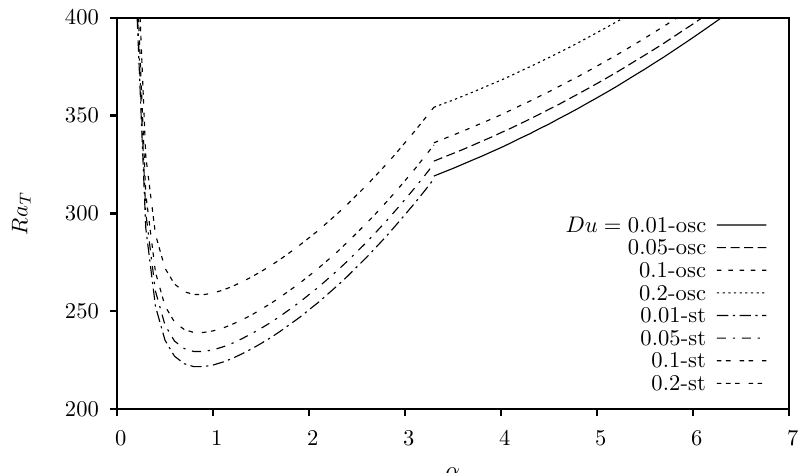
Figure 2. Effect of Du on the marginal stability curves for stationary and oscillatory convection with respect to the wave number α .